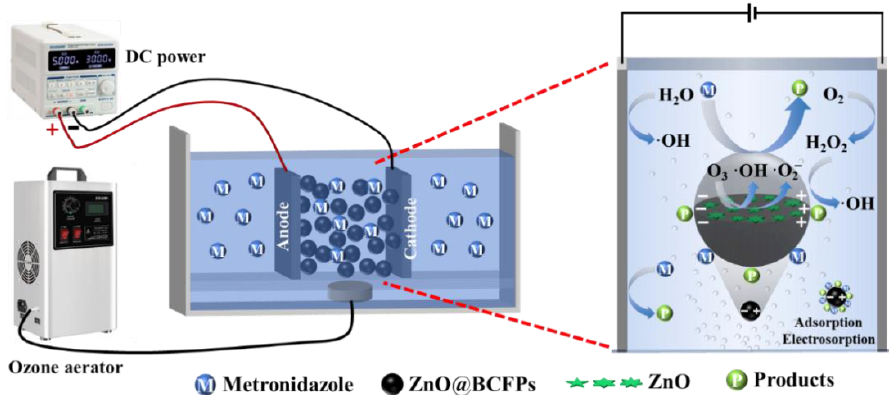
Figure 1. Schematic of self-made 3D electrocatalytic reactor.